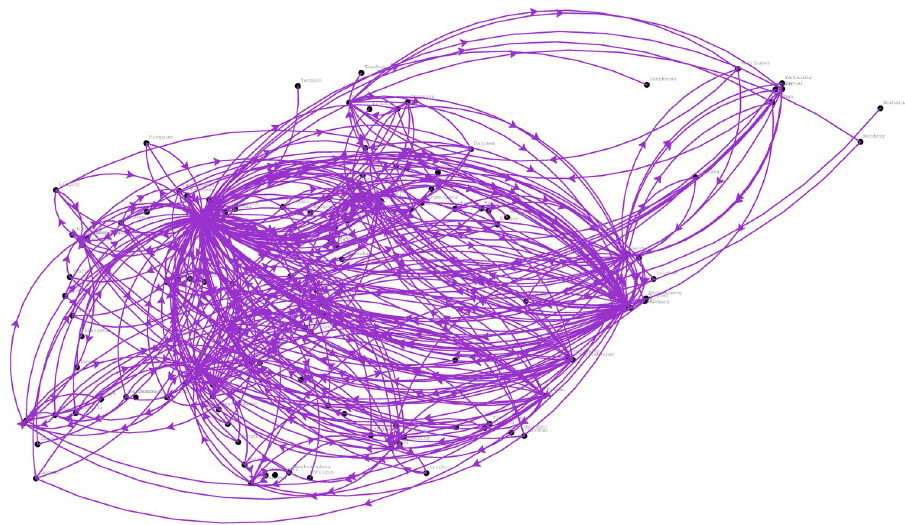
Fig 4. Available train service